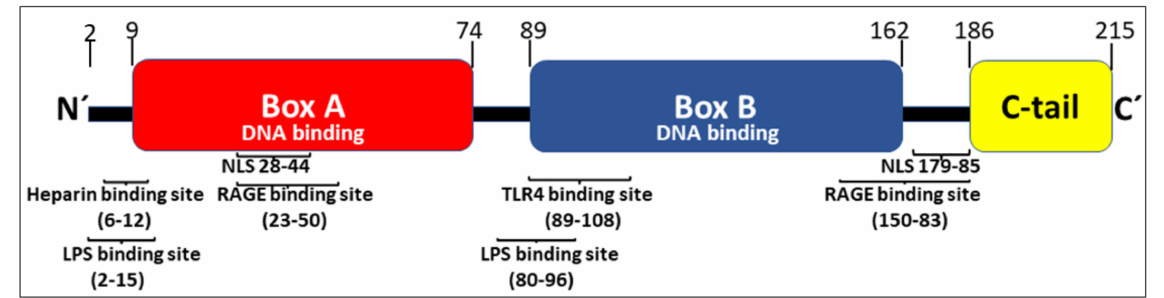
Figure 1. Position of binding sites for HMGB1-receptors, heparin, LPS, and the two nuclear localization sites (NLSs) in the HMGB1